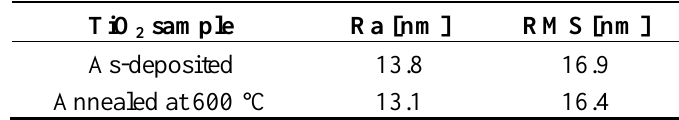
Table 2. Roughness average and root-mean-square values obtained from AFM analysis for as-deposited and annealed at 600 °C titania